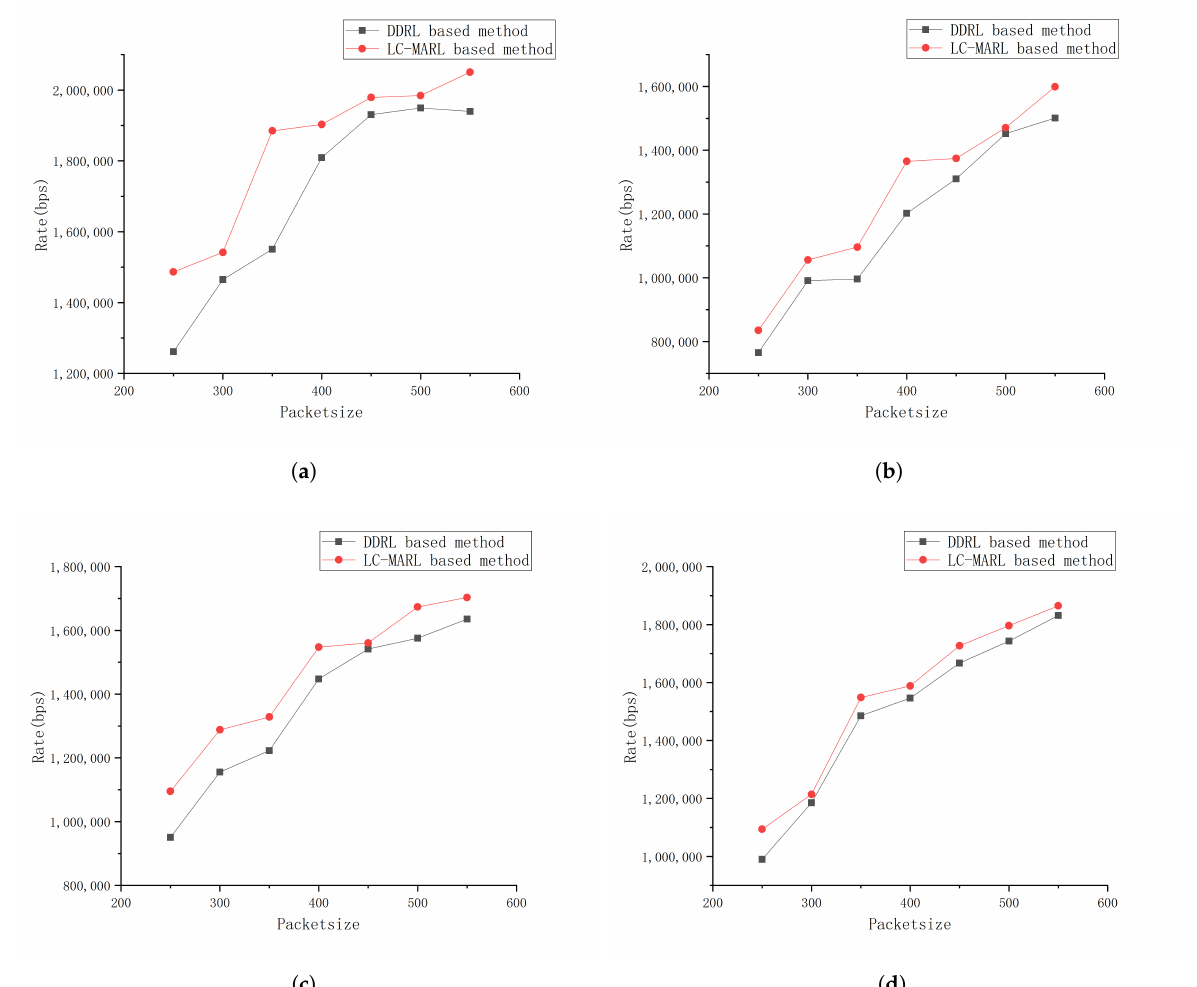
Figure 7. Overall rate comparison in different traffic type. ( a ) high load; ( b ) low load; ( c ) high uplink load; ( d ) high downlink